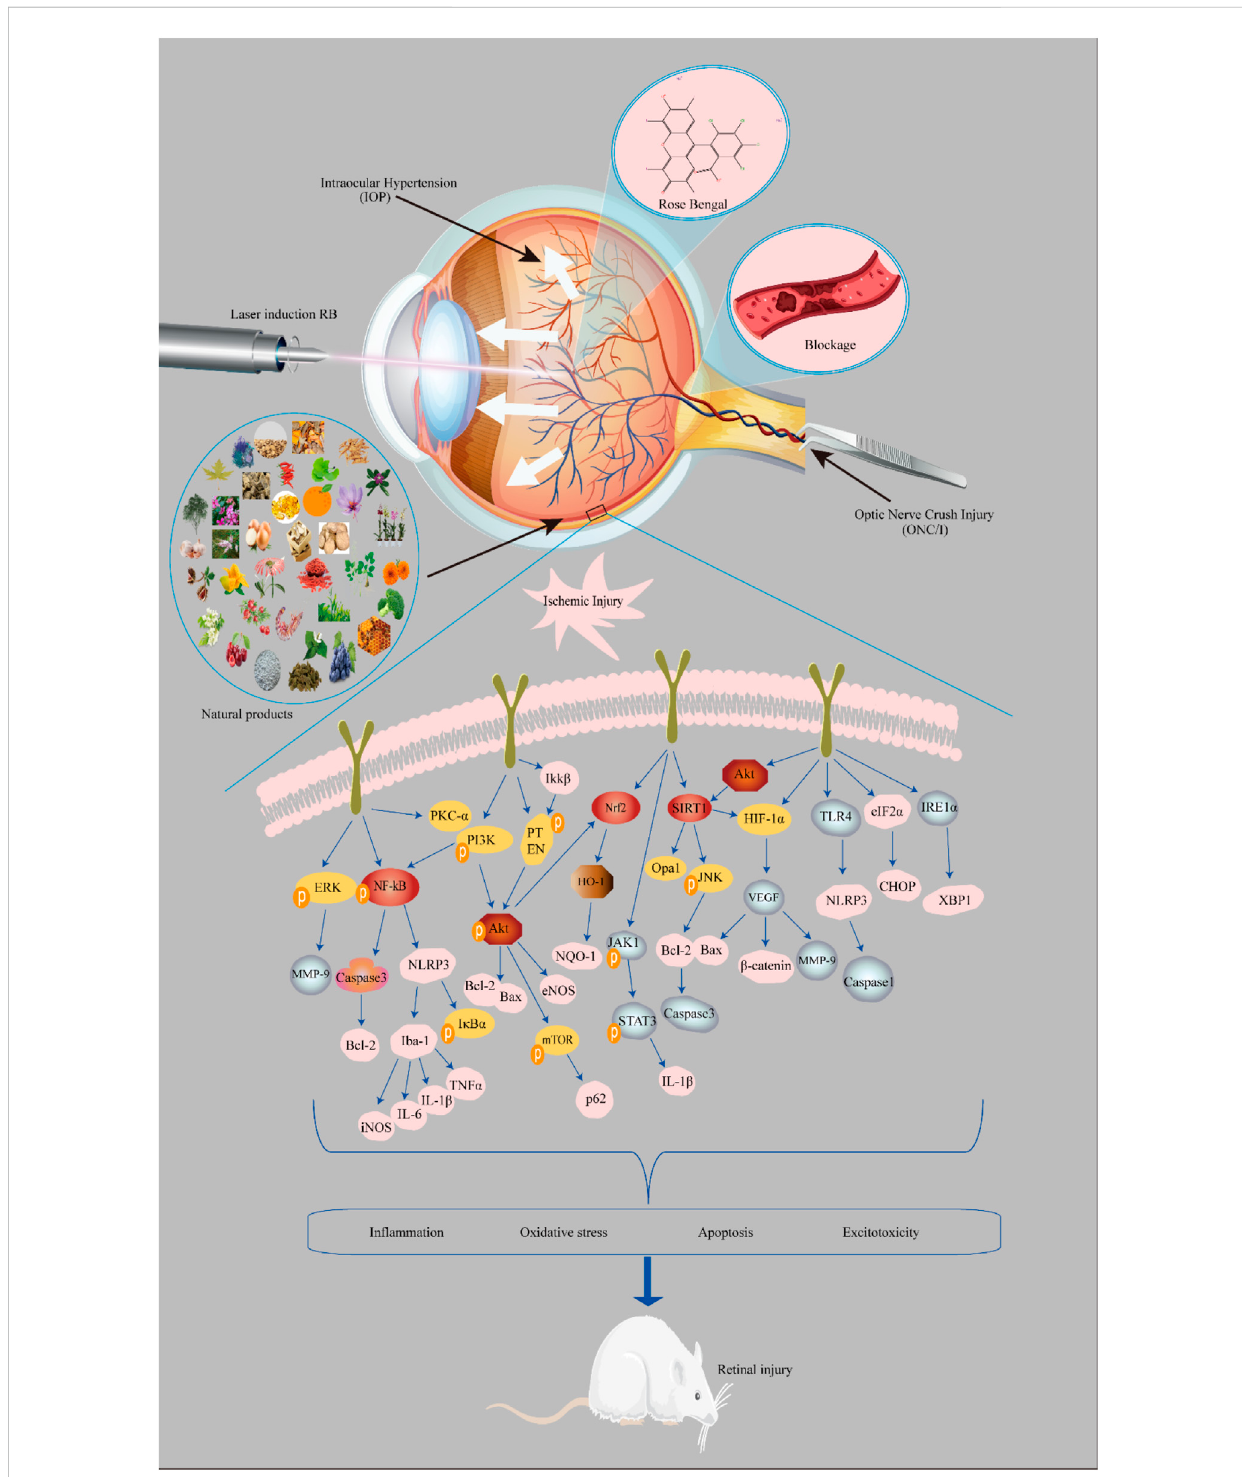
Mechanisms of the neuroprotective effects of natural compounds involved in retinal ischemic injury. Model: 1) intraocular hypertension, 2) laser induction with rose bengal, 3) vascular occlusion, and 4) optic nerve crush